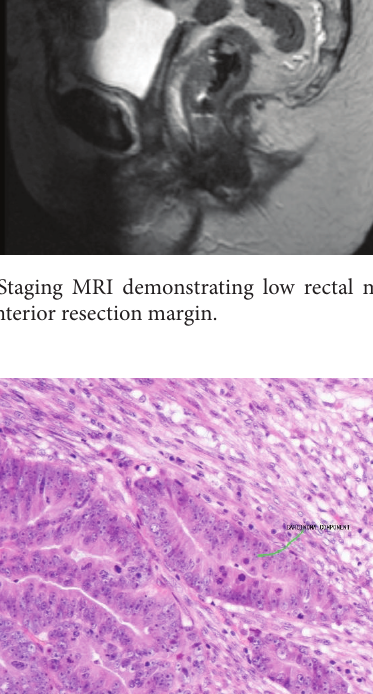
Figure 2: HPE showing distinct areas of carcinoma visible in resected specimen. The carcinomatous segment is well differenti- ated.